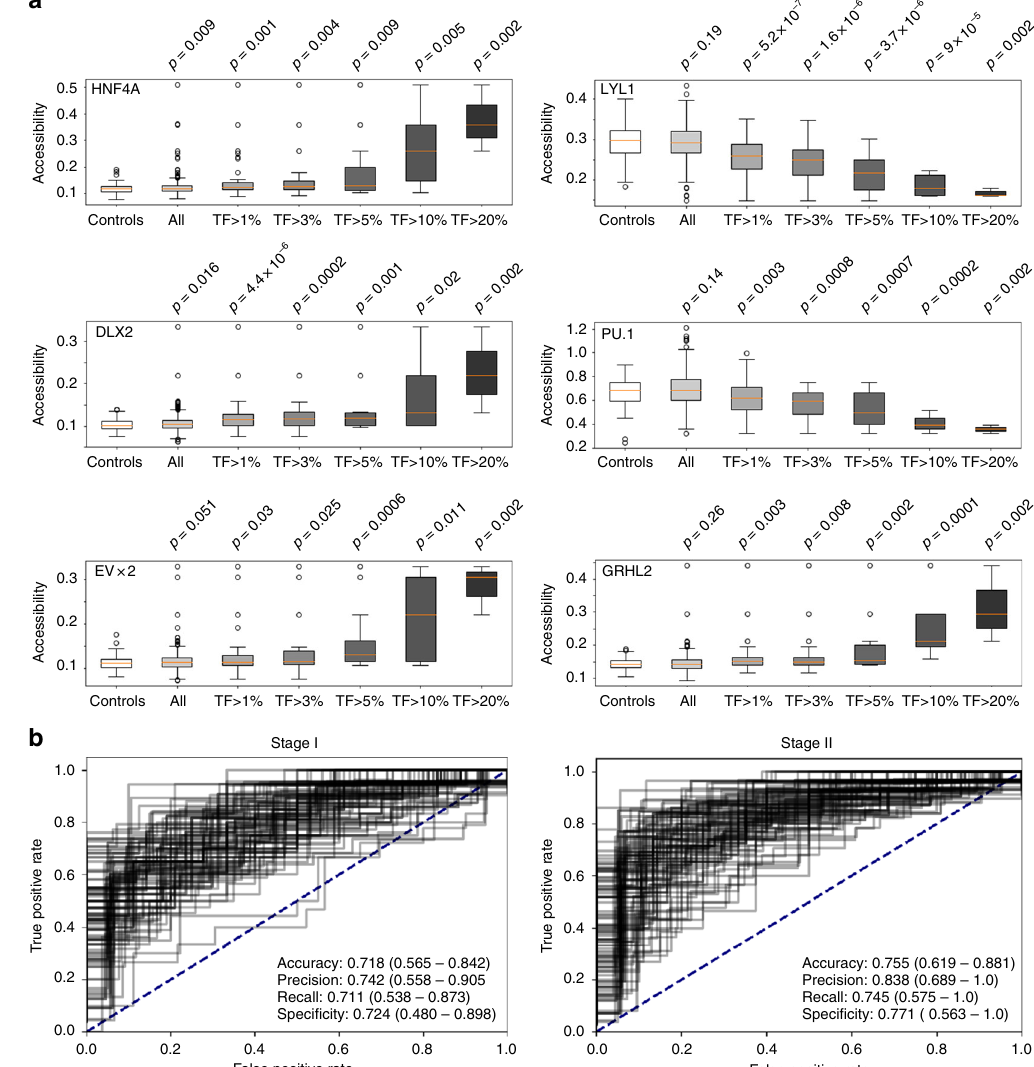
Fig. 4 TF-based plasma resolution limits and early cancer detection. a Comparisons of accessibilities for selected TFs in subsamples of the COAD cohort based on their tumor fraction. Boxplots are de fi ned as follows: centerline represents the median, the box represents the interquartile range (IQR), and the whiskers denote the fi rst quartile – 1.5 IQR and the third quartile + 1.5 IQR, respectively. b Logistic regression with all 504 TFs for samples from the colon cancer cohort with stage I (left panel) and stage II (right panel), respectively. All presented results are cross-validated test-set samples for TFs HNF4A and DLX2 (Fig. 4a) and the other TFs, GRHL2, EVX2, LYL1, and PU.1 showed statistically signi fi cant differences at a 1% tumor level (Fig. 4a).